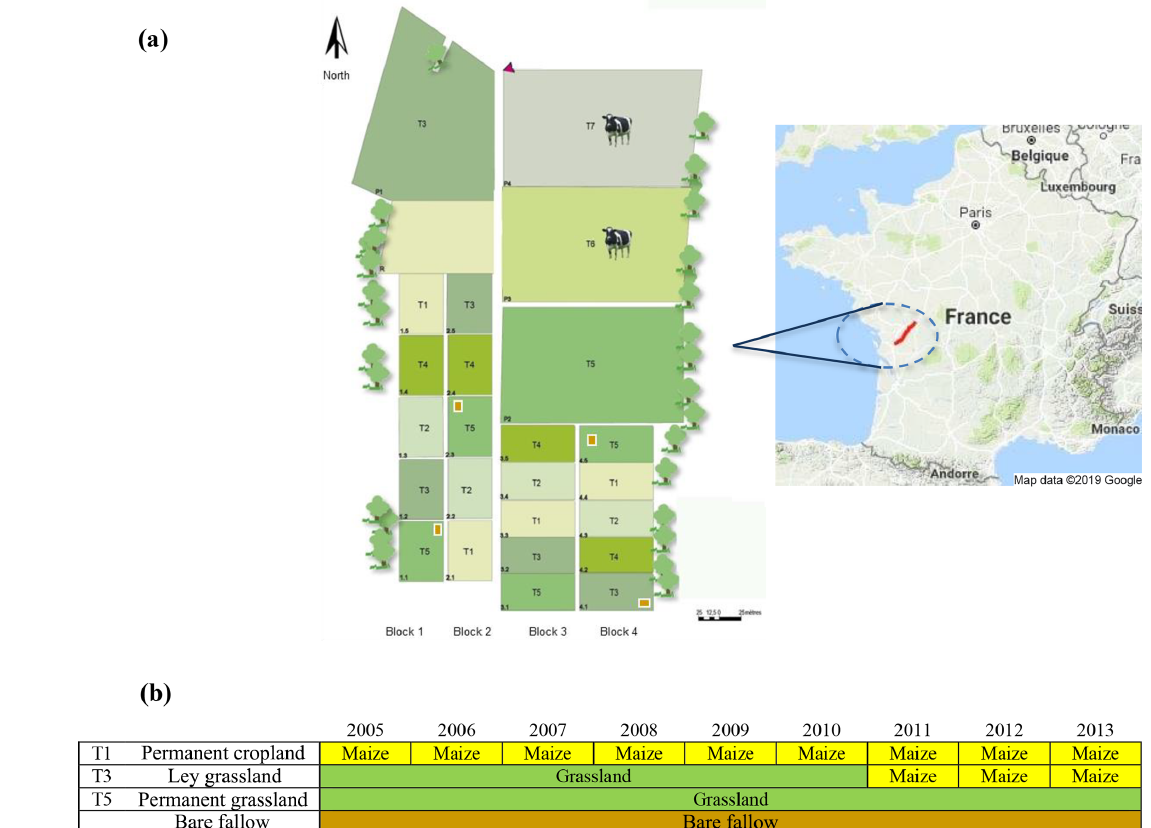
Figure 1. National long-term observatory near Lusignan in the Nouvelle-Aquitaine region, France (a) . Land-use management of target treatments from 2005 to 2013 used in this study before the sampling (b) . Continuous maize bands were installed in the subplots of the T1 and T3 treatments in addition to bare fallow areas that have not received fresh organic matter input since the start of the experiment in 2005. Map data: ©2019 Google